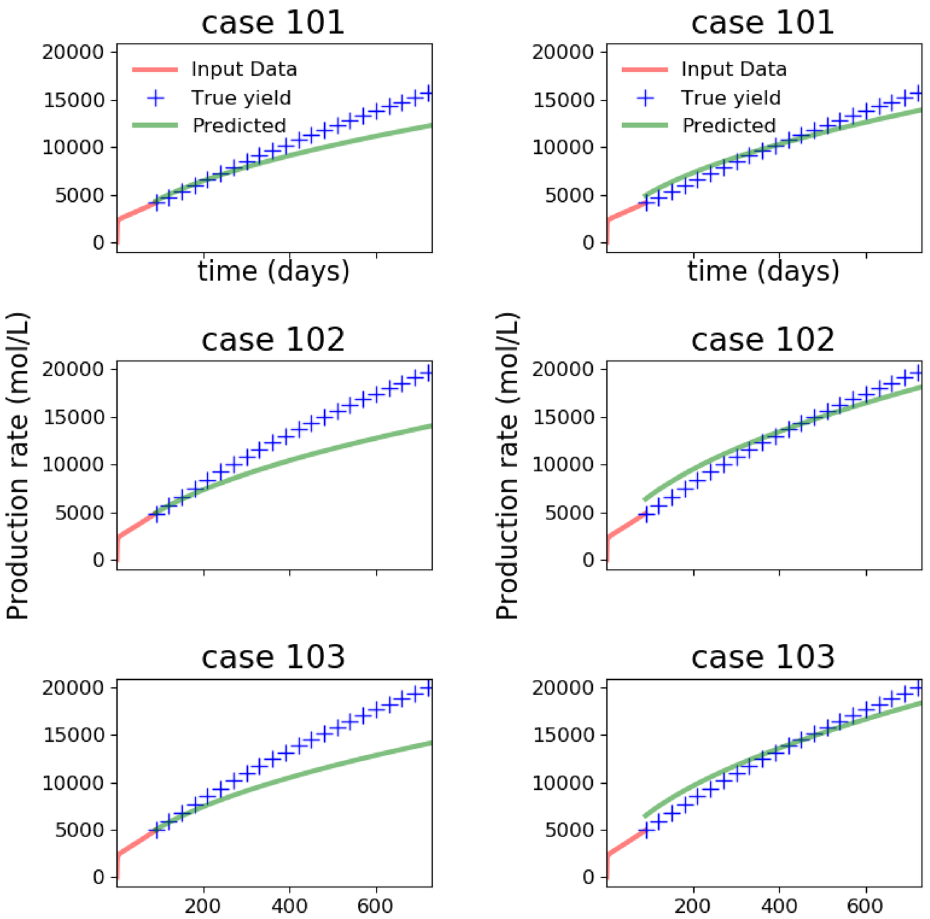
Figure 10. Predicted production profile obtained with Patzek reduced-order model from the ANN with parameter loss function (8) before (left) and after (right) transfer learning with data from 100 DFN simulations. Observe that training with small amount of high-fidelity data from DFN simulations allows the ANN to capture the production profile generated by a high-fidelity model, but without transfer learning, the predicted results are not